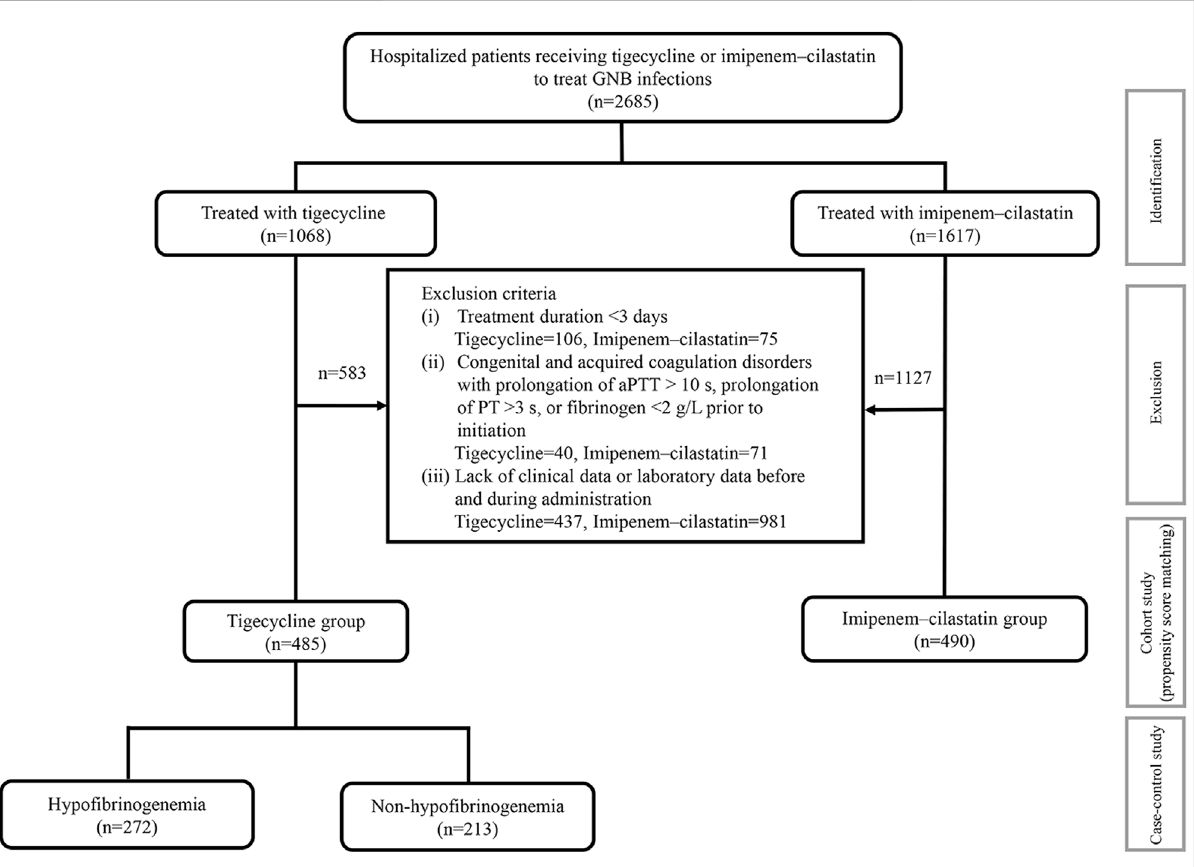
FIGURE 1 The detailed study process. 975 patients were enrolled from 2,685 hospitalized patients with de fi nite or suspected infections of GNB into this study. A cohort study was performed in 485 patients receiving tigecycline and 490 patients receiving imipenem-cilastatin. Propensity score- matchedanalysis wasusedforbalancingbaselinecharacteristics.272patientswithhypo fi brinogenemiainthetigecyclinetreatmentwerecompared with 213 non-hypo fi brinogenemia patients in the same cohort using the case-control study. aPTT: activated partial thromboplastin time; PT: prothrombin